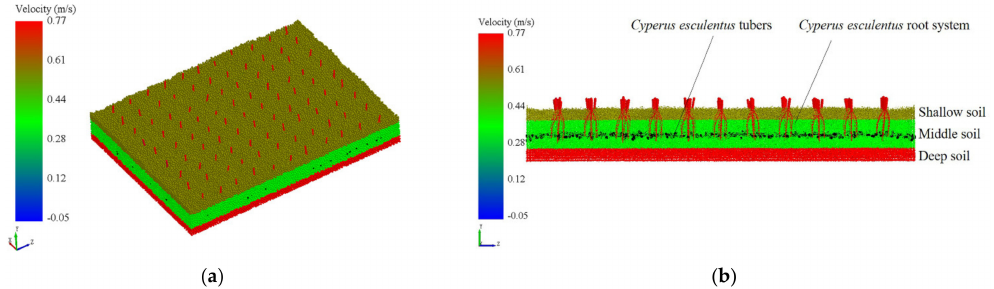
Figure 11. Cyperus esculentus agglomerate. ( a ) The overall model of Cyperus esculentus agglomerate; ( b ) the vector model of the Cyperus esculentus agglomerate.